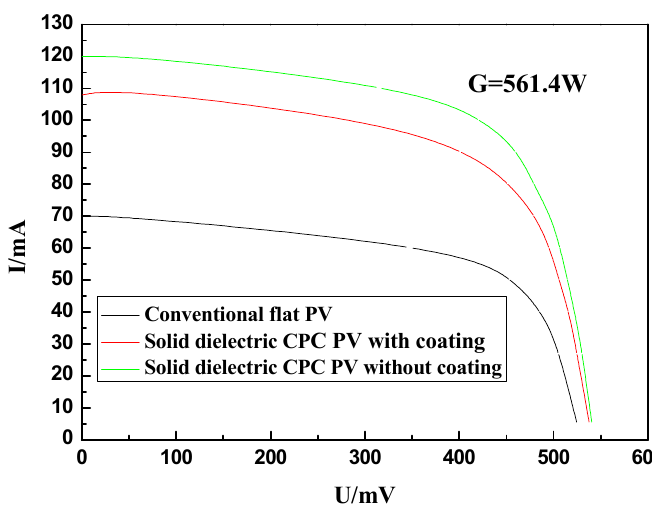
Figure 6. I-V curve for 0° incidence